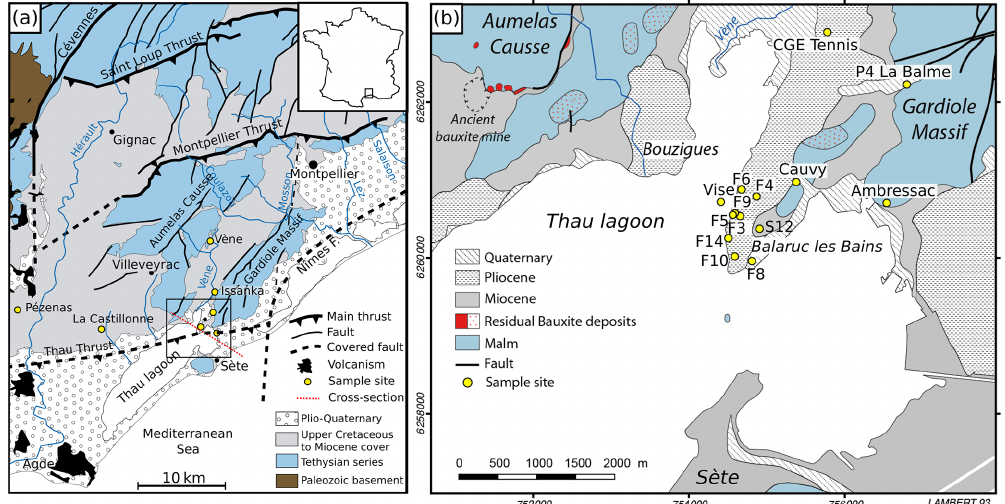
Figure 1. (a) Simplified geological map showing the main structures of the Montpellier region. The box shows the Balaruc-les-Bains study area between the Montpellier Thrust and the Nîmes Fault. (b) Detailed geological map of the eastern Thau Lagoon. Sample sites indicated by the yellow dots in both maps correspond to the locations of the thermal wells, karst springs, and other piezometric drilling sites. The location of the ancient bauxite mine (Cambelliès) is indicated by the dashed oval in the north-west of the study area. Table 1. Summary of the observed occasional saltwater intrusions (inversac events) in the karst and thermal aquifer of the Thau basin.